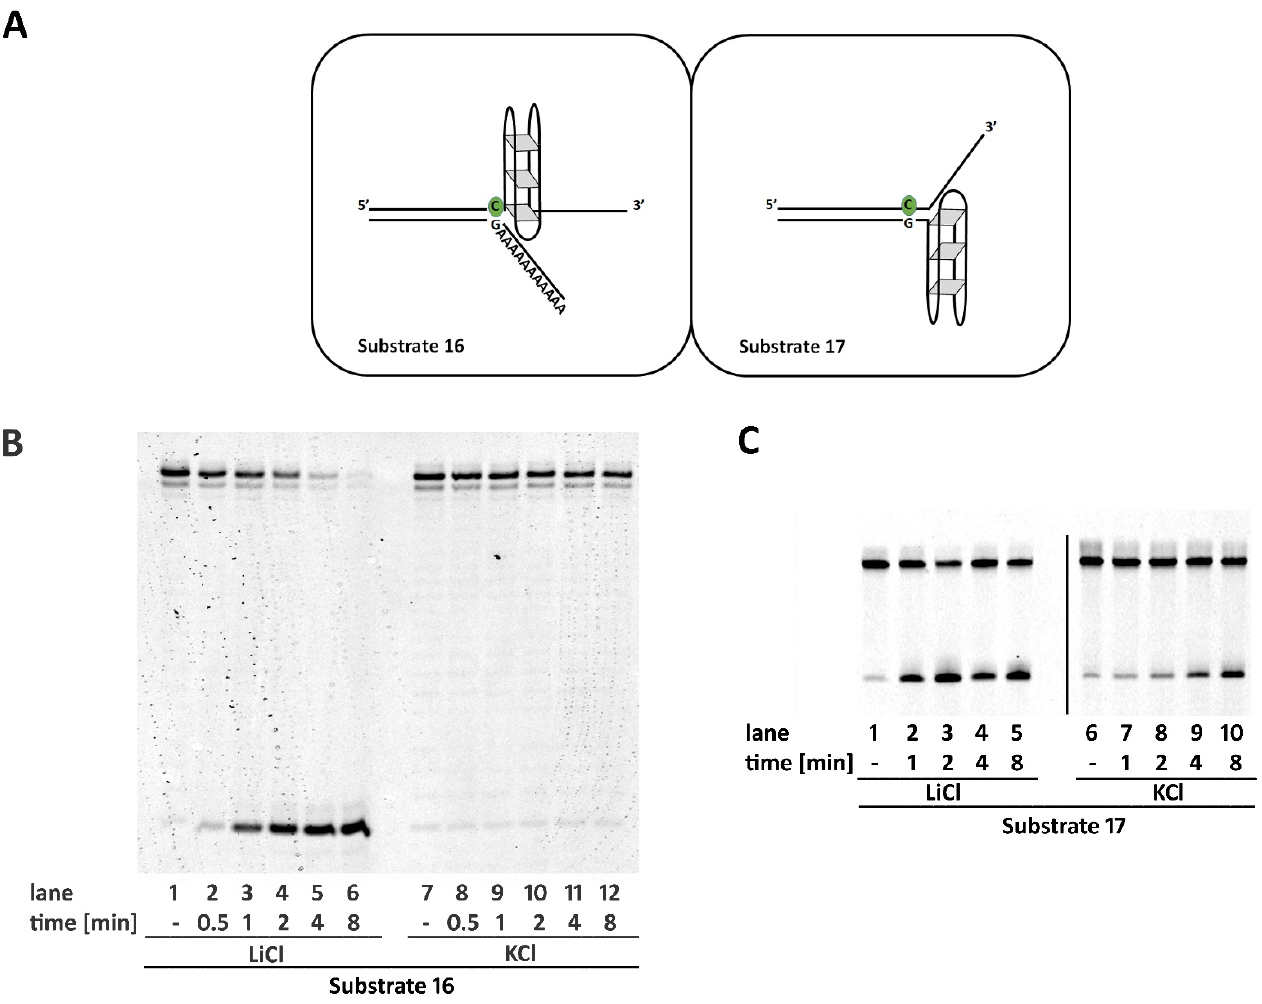
Figure 4. A G4 structure on the same strand and flanking the 3 ′ of a single ribonucleotide impairs RNase H2 activity. ( A ) schematic representation of Substrates 16 and 17 annealed in the presence of KCl. Time course reactions were performed as described in materials and methods using 20 nM of Substrate 16 ( B ), or 17 ( C ), annealed in the presence of KCl (allowing G4 formation), or in the presence of LiCl (not allowing G4 formation). Unprocessed substrates and reaction products are indicated at the left of each panel (44mer and 22mer respectively).